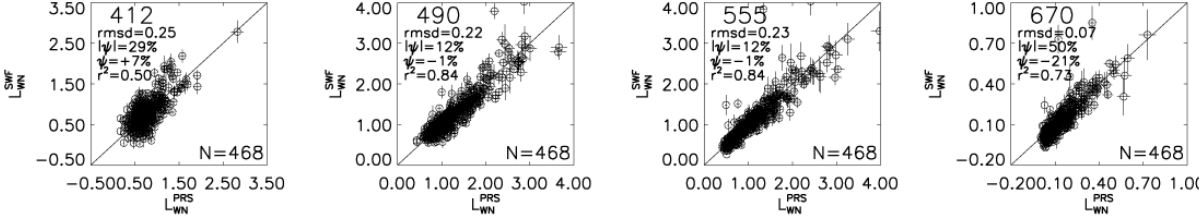
Fig. 7. Scatter plots of SeaWiFS (SWF) versus AERONET-OC (PRS) L WN match-ups at selected center wavelengths determined at the AAOT with 1t =± 1h. Symbols and units are the same as in Fig. 1.